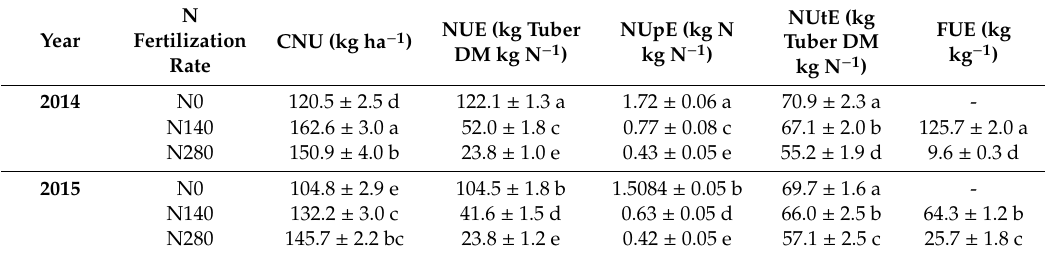
Table 5. CNU, NUE, NUpE, NUtE and FUE as a ff ected by ‘N fertilization rate × year’ interaction. Di ff erent letters within each column indicate significant statistical di ff erences (LSD test, p < 0.05).